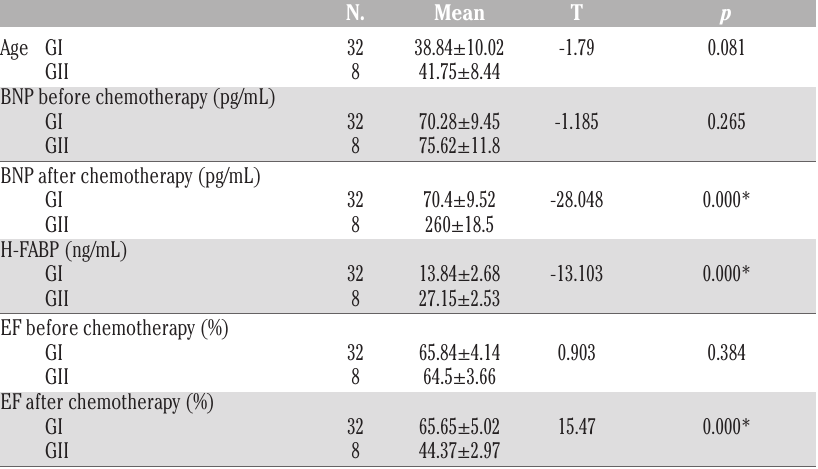
Table 2. Comparison between group I and II patients as regards BNP and H-FABP.